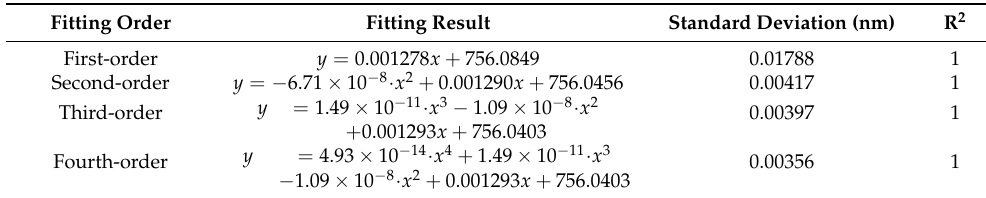
Table 8. Fitting results of the corresponding relationship between the center wavelength of the molecular oxygen A-band observation channel (channel 1) and the PBSC.